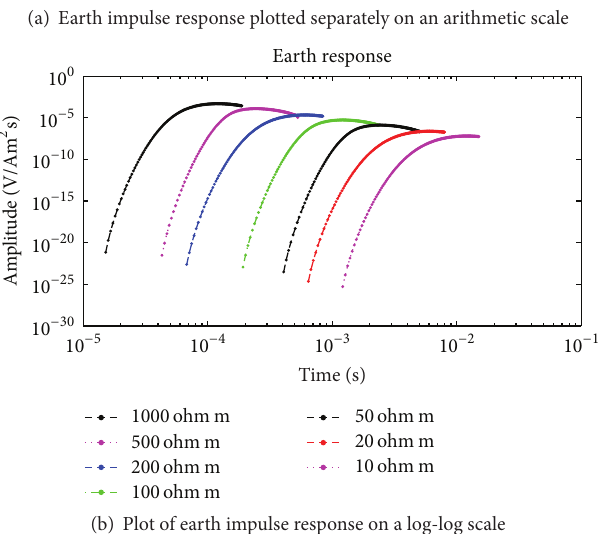
Figure 11: MTEM earth response over subsurface material with different